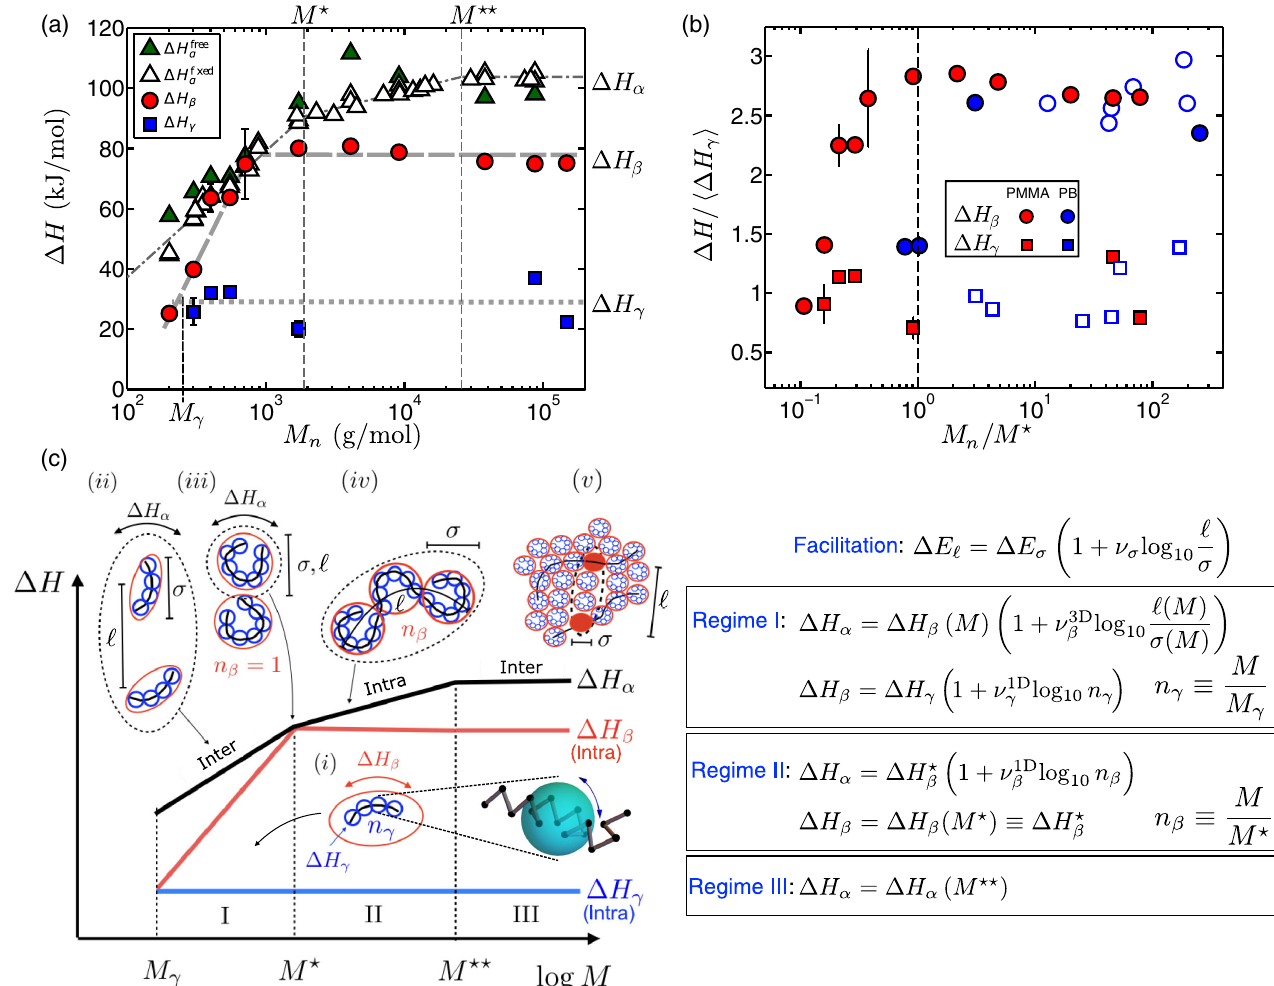
M Þ for PMMA. Note that Δ H α ð M Þ data were determined from T M Þ using a fixed FIG. 5. (a) Activation enthalpies Δ H α ; β ; γ ð g ð ⋆ , and M ⋆⋆ 10 − 12 s (open triangles) or from the VFT fits in Fig. 1(b), as discussed in the text (filled triangles). Here, M τ 0 ¼ γ , M (described in the text) are marked as vertical dashed lines. The horizontal lines signify the average values of Δ H γ (dotted, M > M γ ), ⋆ Þ for PMMA and PB, normalized by their respective Δ H Δ H Δ H β (dashed, M > M (cid:2) ), and α (dot-dashed, M > M (cid:2)(cid:2) ). (b) β ; γ ð M=M averages h Δ H γ i ; PB data from the literature [70 – 75] are shown as open symbols. Error bars in panels (a) and (b) represent the standard deviations obtained through least-mean-squares fitting of the secondary relaxation time data shown in Fig. 1(b). (c) Sketch of the M Þ for polymers. The equations describe the activation enthalpies due to facilitation in the activation enthalpy behavior for Δ H α ; β ; γ ð different regimes, and the five cartoons (i) – (v) are described in detail in the